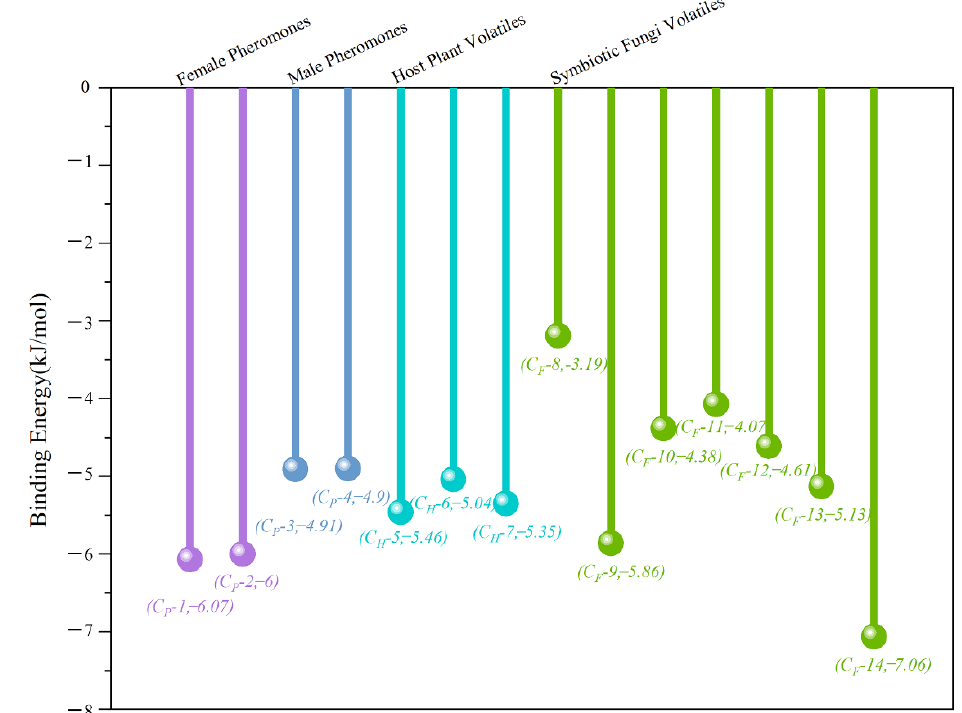
Figure 5. Binding energy of 14 ligands docked to the SnitCSP4